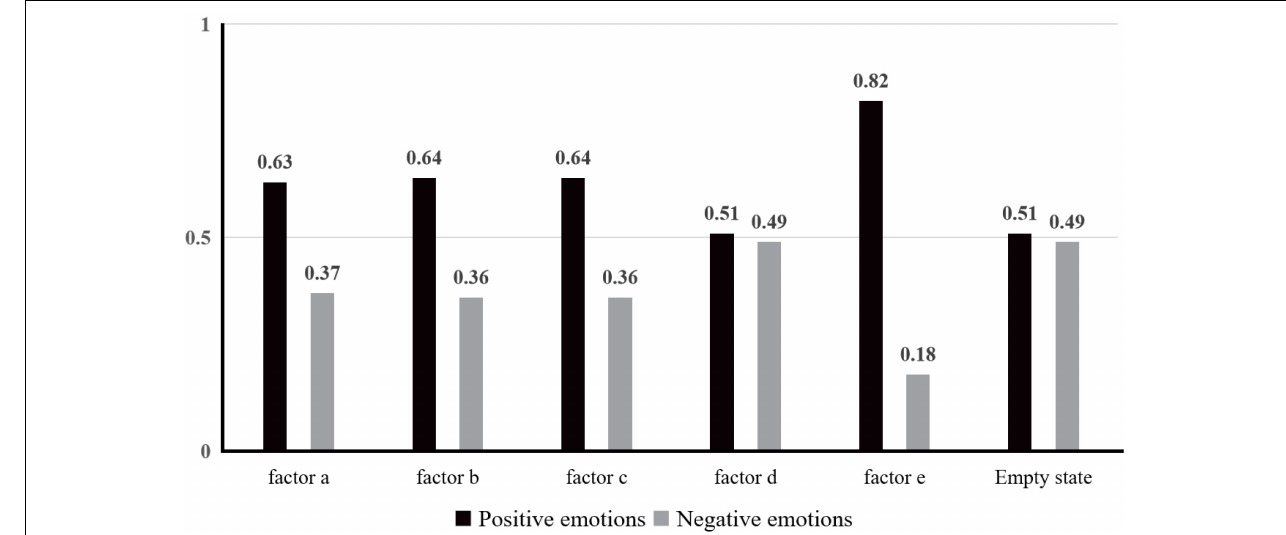
FIGURE 3 | Comparison of positive and negative